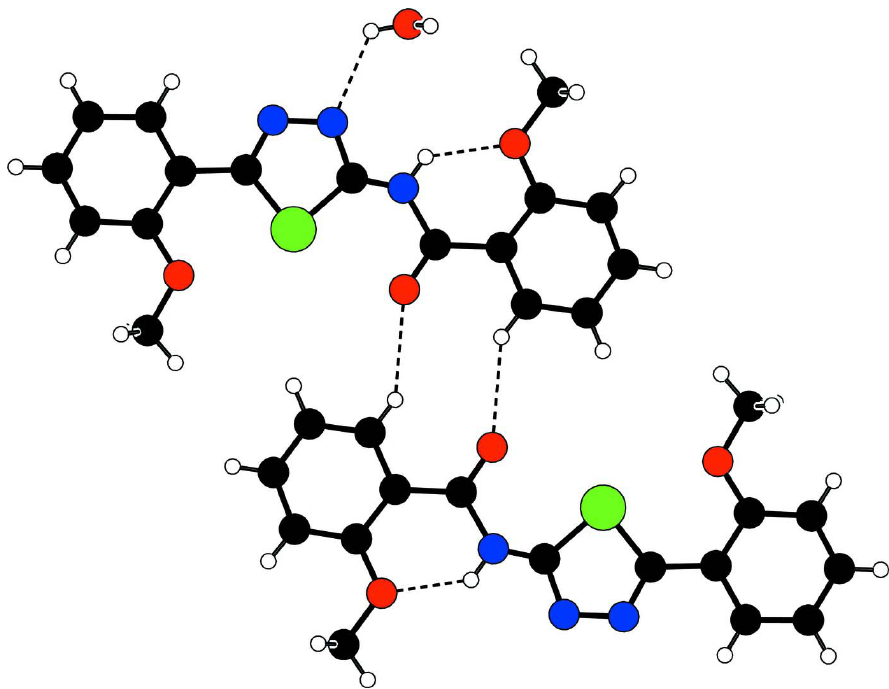
Figure 2 A partial packing diagram of the title compound. Hydrogen bonds are shown as dashed lines. 2-Methoxy- N -[5-(2-methoxyphenyl)-1,3,4-thiadiazol-2-yl]benzamide hemihydrate Crystal